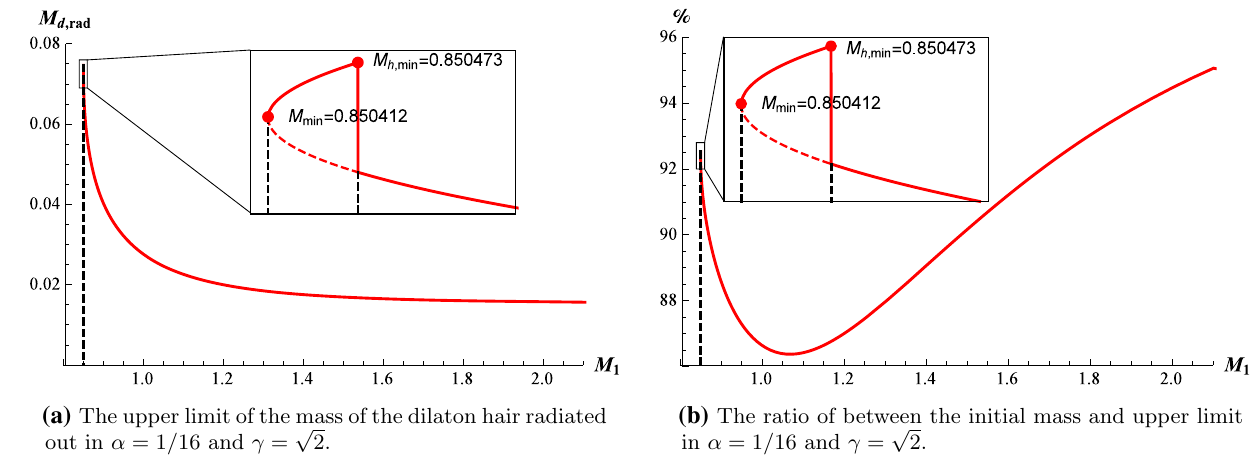
(b) The ratio of between the initial mass and upper limit √ in α = 1 / 16 and γ = 2.